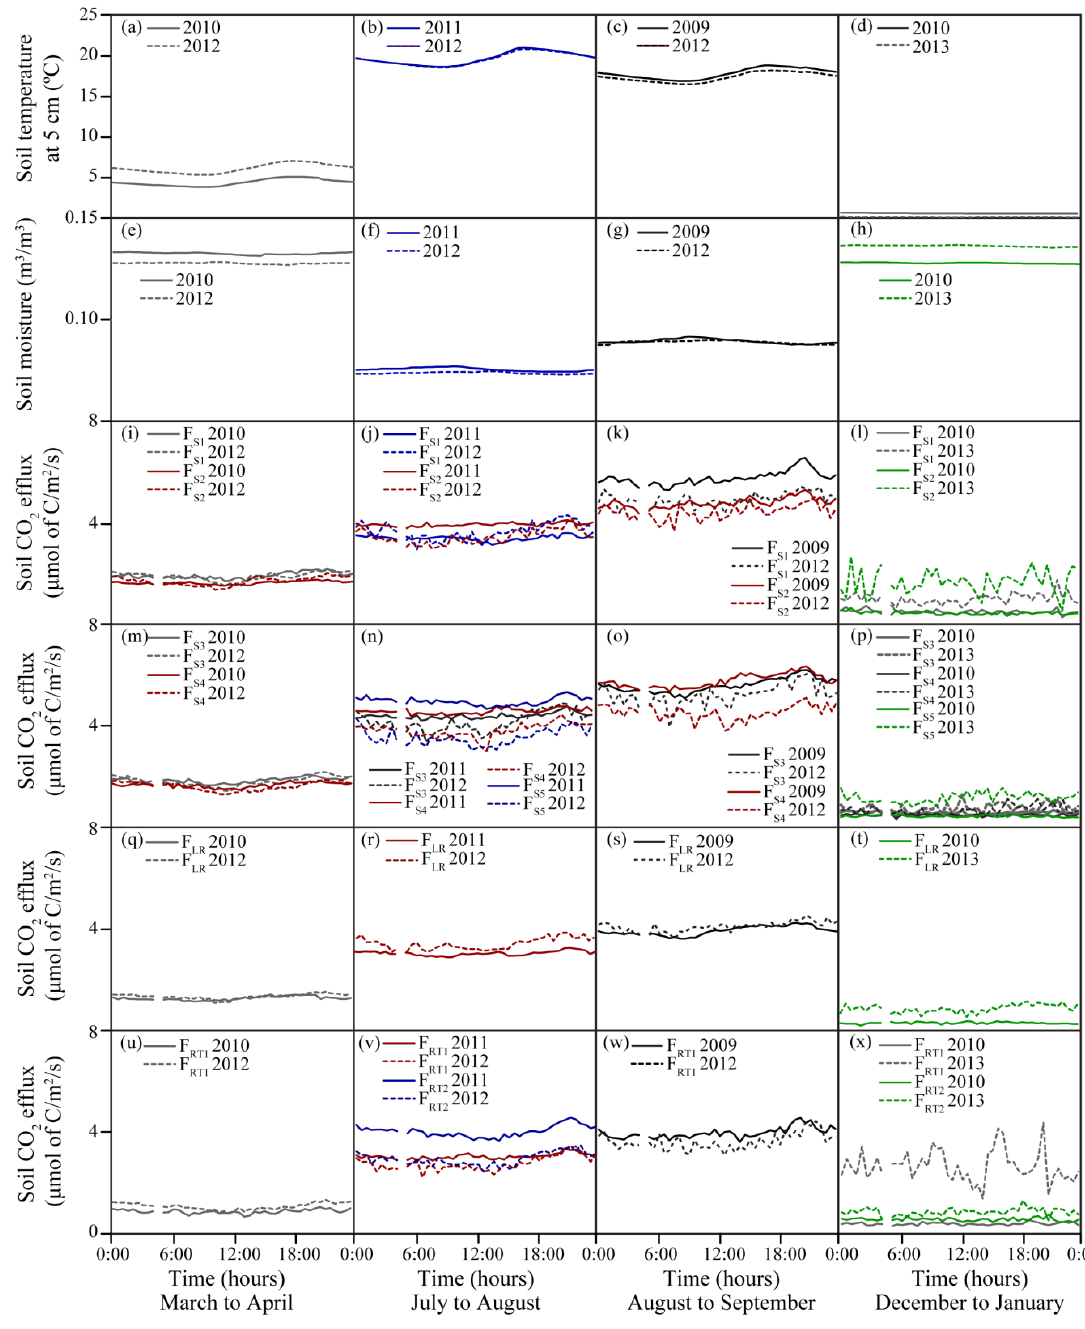
Figure 2. Two-month averages of the diurnal pattern for: soil temperature at 5 cm depth in ( a ) March to April, ( b ) July to August, ( c ) August to September and ( d ) December to January; soil moisture averaged between 0 to 30 cm depth for ( e ) March to April, ( f ) July to August, ( g ) August to September and ( h ) December to January; mineral-soil CO 2 efflux (F LR ) for ( i ) March to April, ( j ) July to August, ( k ) August to September and ( l ) December to January; root trenched CO 2 efflux (F RT ) for ( m ) March to April, ( n ) July to August, ( o ) August to September and ( p ) December to January; initial group of control (F S1 and F S2 ) chambers for ( q ) March to April, ( r ) July to August, ( s ) August to September and ( t ) December to January; and latest group of control (F S3 , F S4 and F S5 ) chambers for ( u ) March to April, ( v ) July to August, ( w ) August to September and ( x ) December to January. Diurnal average patterns from pre- (solid line) and post- (dotted line) harvesting event in 2012 are compared with the same months that have similar average temperature and total